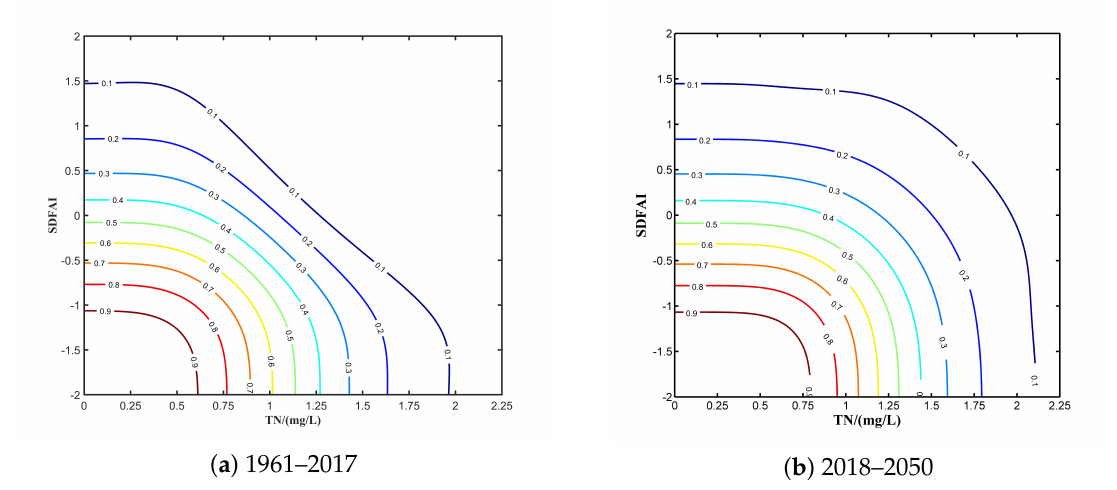
Figure 6. The contour plot of bivariate JPD of TN and SDFAI. Table 3. The possibility of different bivariate combination